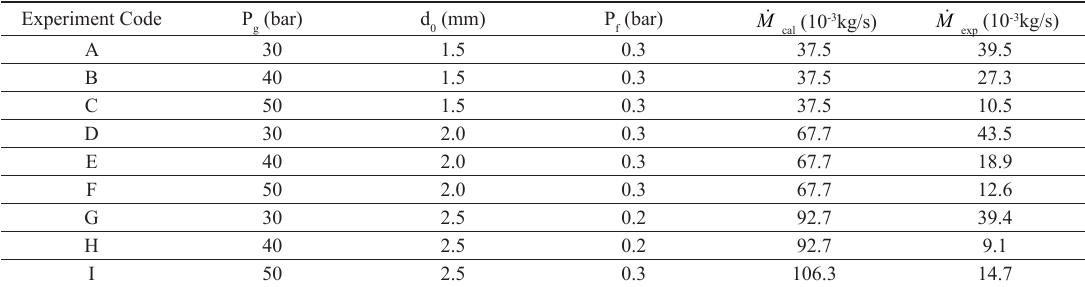
Table 4. Calculated and experimental metal flow rate for each experiment. Experiment